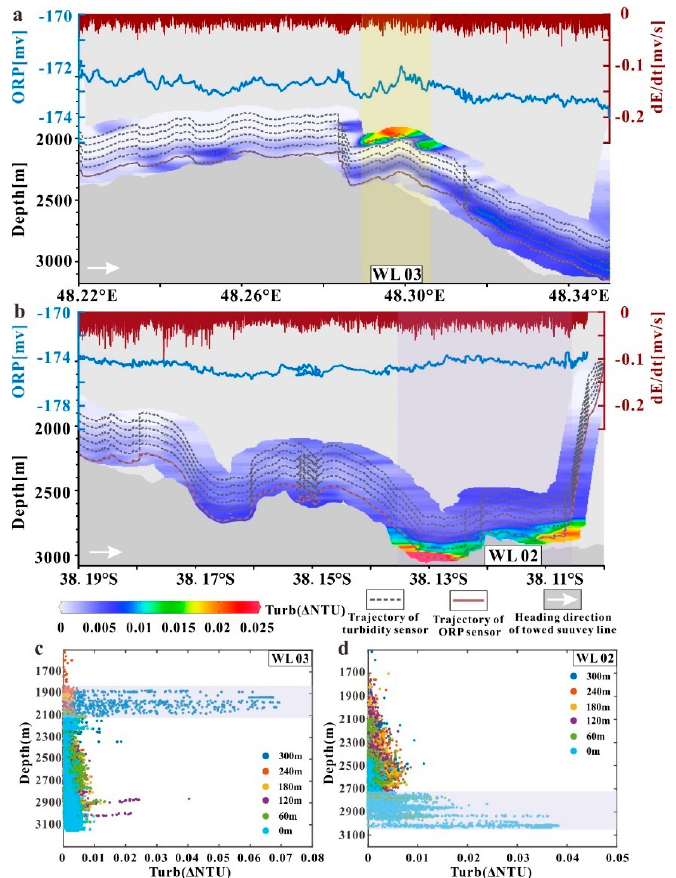
Figure 5. Horizontal and vertical distribution of hydrothermal plume along DHDS lines. ( a , b ) The seafloor relief, Δ NTU, ORP and negative dE/dt along lines WL03 and WL02, respectively. The top blue line is ORP and the top brown line is dE/dt. The yellow band indicates an inferred hydrothermal anomaly site, and the purple band indicates a suspected one. Both panels use the same colorbar and legend. ( c , d ) The vertical Δ NTU variation of lines WL03 and WL02, respectively; dots in various colors represent different heights of turbidity sensors above the towed body. The transparent band marks the depth layer of NTU anomaly.